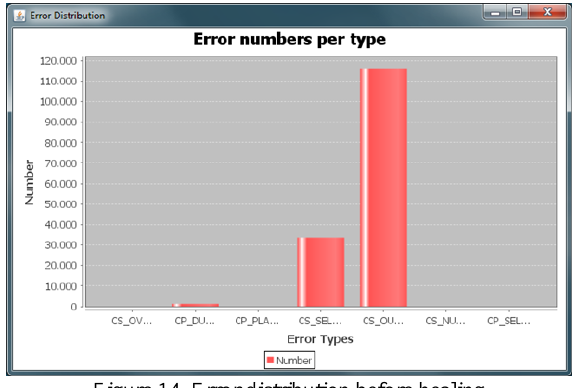
Figure 14. Error distribution before healing